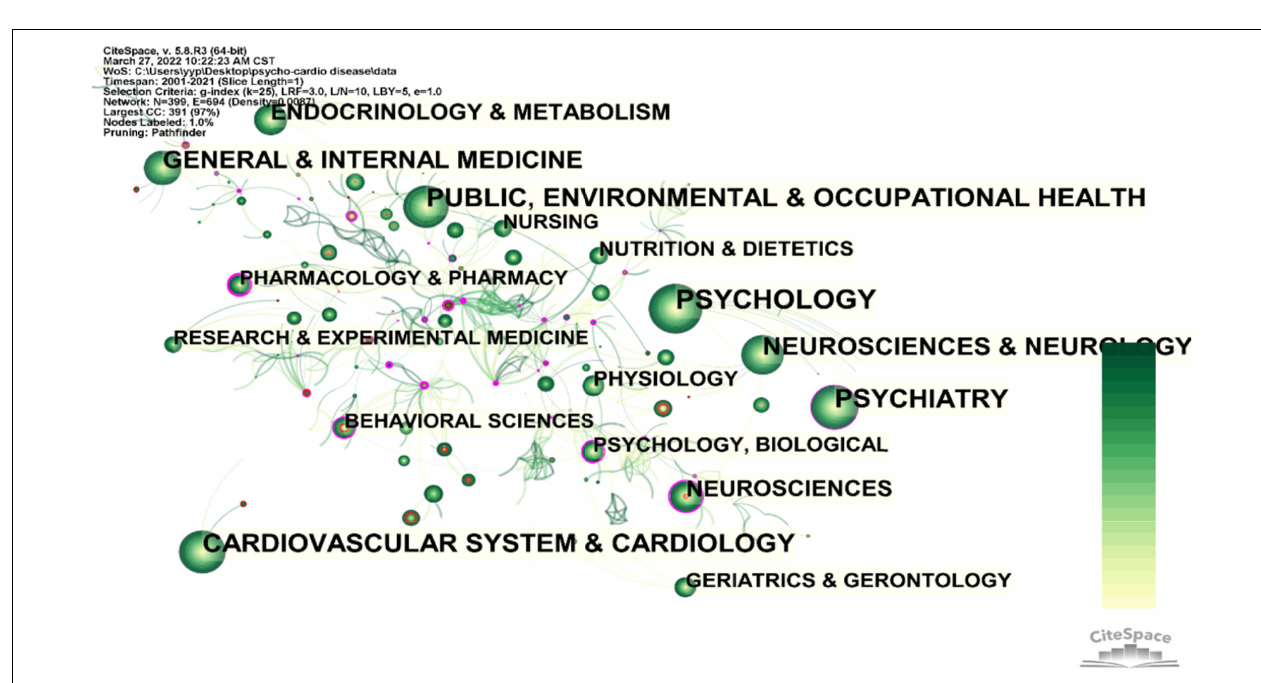
FIGURE 3 | Subject category coexistence of publications about the psycho-cardiological disease and related literature.